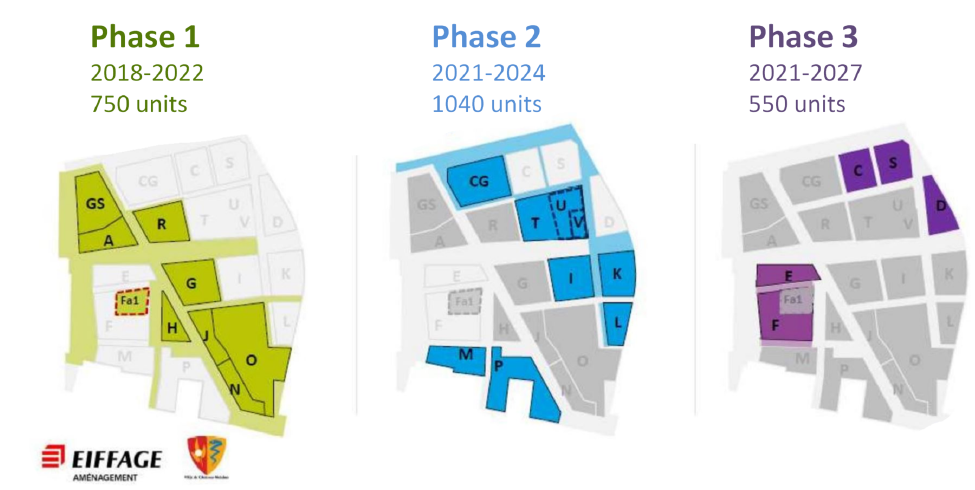
Figure 6. Three phases of development. ©SEMOP Châtenay-Malabry Parc